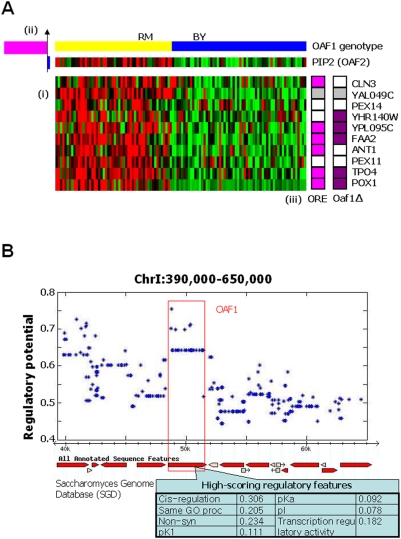
The peroxisome module.(A) The module contains 10 target genes (i), regulated by 2 predicted regulators (ii) – a genetic region on chromosome 1 containing OAF1, and the expression pattern of PIP2, the other component in the Oaf1-Pip2 heterodimer. (iii) Six of the target genes (POX1, FAA2, TPO4, ANT1, YPLO95C and CLN3) contain a canonical Oaf1 binding site (ORE) [29]. The two predicted regulators and five of the target genes are among the most significantly down regulated RNA transcripts in an oaf1Δ microarray with the following ranks: POX1 (1st), YPL095 (2nd), FAA2 (5th), YHR140W (14th), TPO4 (23rd), OAF1 (9th), PIP2 (29th). (B) The genetic region on chromosome 1, with the inferred regulatory potentials for each of the SNPs it contains (Table S8). Also shown are the regulatory features that contributed to the selection of a SNP in Oaf1 as the causal polymorphism.